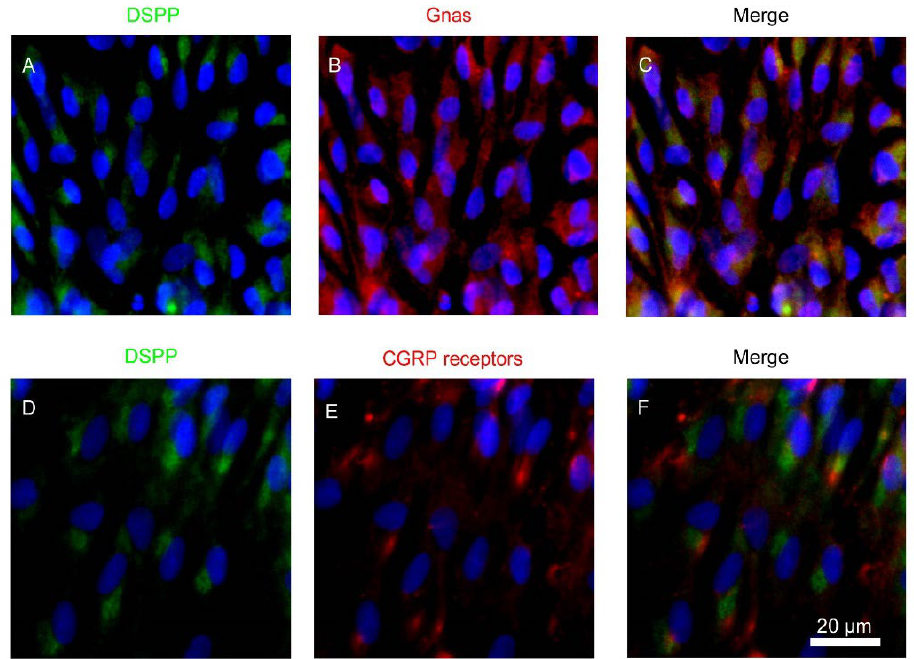
Figure 1. Expression of the heterotrimeric G-protein α -subunit G α s (Gnas) and calcitonin receptor-like receptor (CALCRL) in rat odontoblasts. ( A – F ) Odontoblasts in dental pulp slice preparations showed positive immunoreactivity to DSPP (green in A , C , D , F ), Gnas (red in B , C ), and calcitonin receptor-like receptor (CALCRL) (red in E , F ). Nuclei are colored blue. Scale bar: 20 µ m. No fluorescence was detected in the negative controls (not shown). Data were obtained using a 40 × magnification objective lens under a microscope. Enlarged images are shown as representative areas.